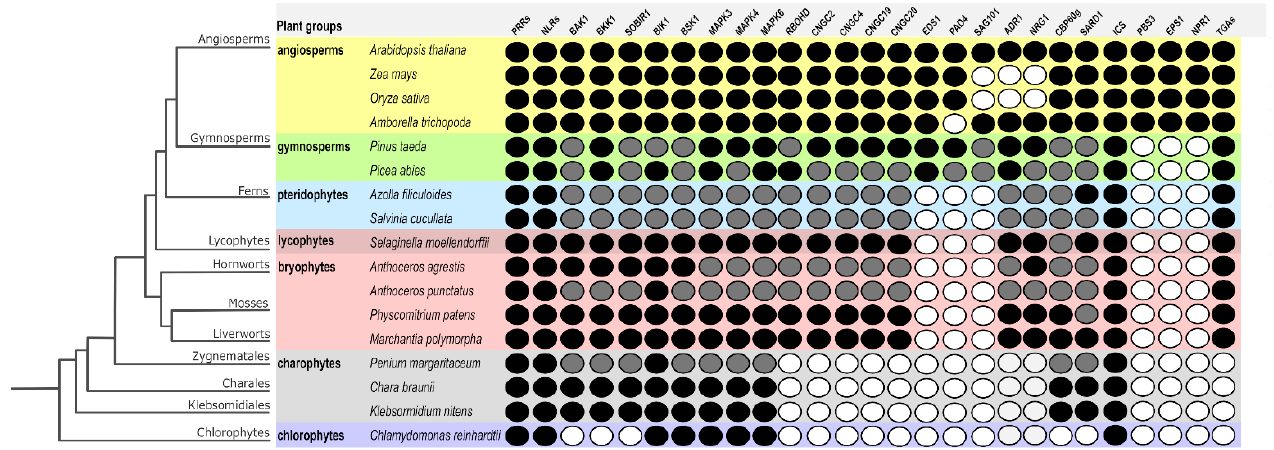
Figure 5. Presence/absence analysis of canonical components connecting PTI and ETI along the plant kingdom. Rows denote species, which are arranged according to [222], with some modifications. Columns denote the presence or absence of known components connecting PTI and ETI. Filled circles indicate presence and clear circles represent absence, as defined by reciprocal BLAST. In the case of filled circles, black-filled denote the result of BLAST plus the domain-oriented orthology inference approach, whereas gray-filled are based on parsimony inference. Created with Inkscape (https://inkscape.org) and GIMP v2.10.24 (https://www.gimp.org).